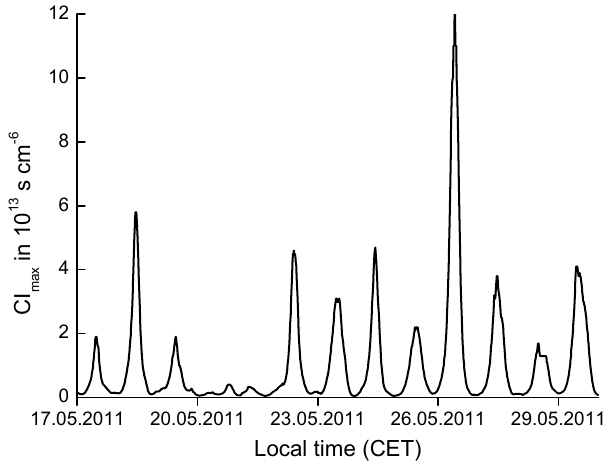
Figure 5. Daily maximum of the convolution integral CI for all ob- servation days as a function of the time of day of that maximum. Event classes were defined as Class I (red, intense new particle for- mation), Class II (blue, new particle formation at lower intensity), and Class III (green, NPF below significance level). See Table 2 for the exact threshold